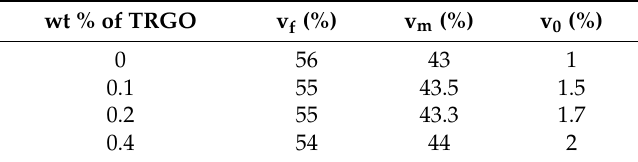
Table 1. Volume fraction of theconstituent materials in the TRGO/CF/epoxy